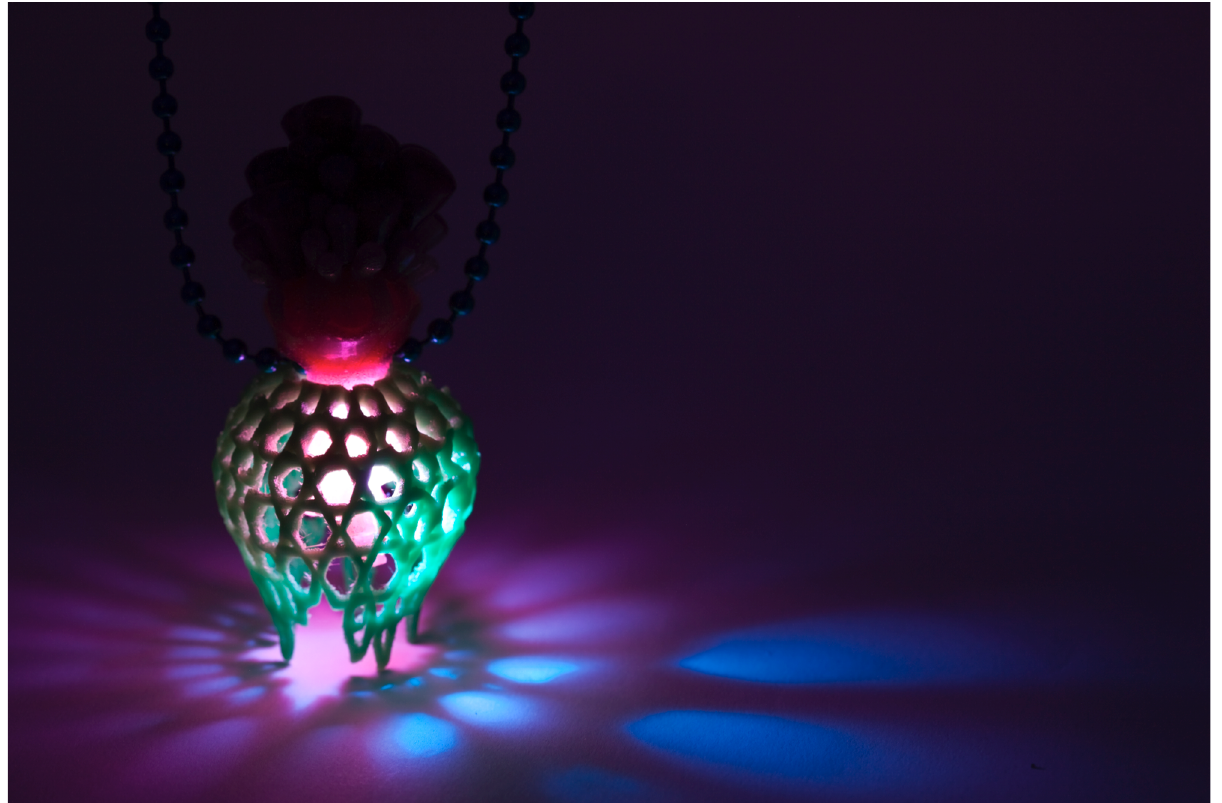
Figure 14 | Hyperhive: Hypertilt Pendant in active state (3 of 5), Katharina Vones